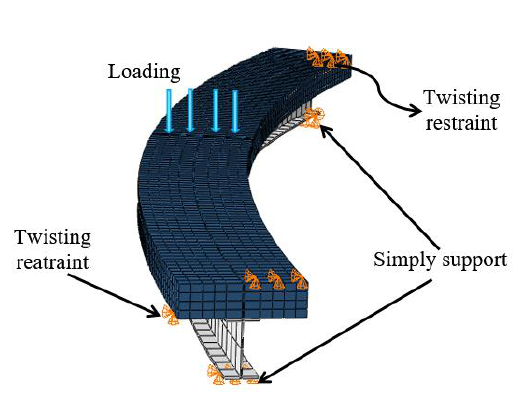
Figure 6. Boundary and applied loading conditions for the finite element